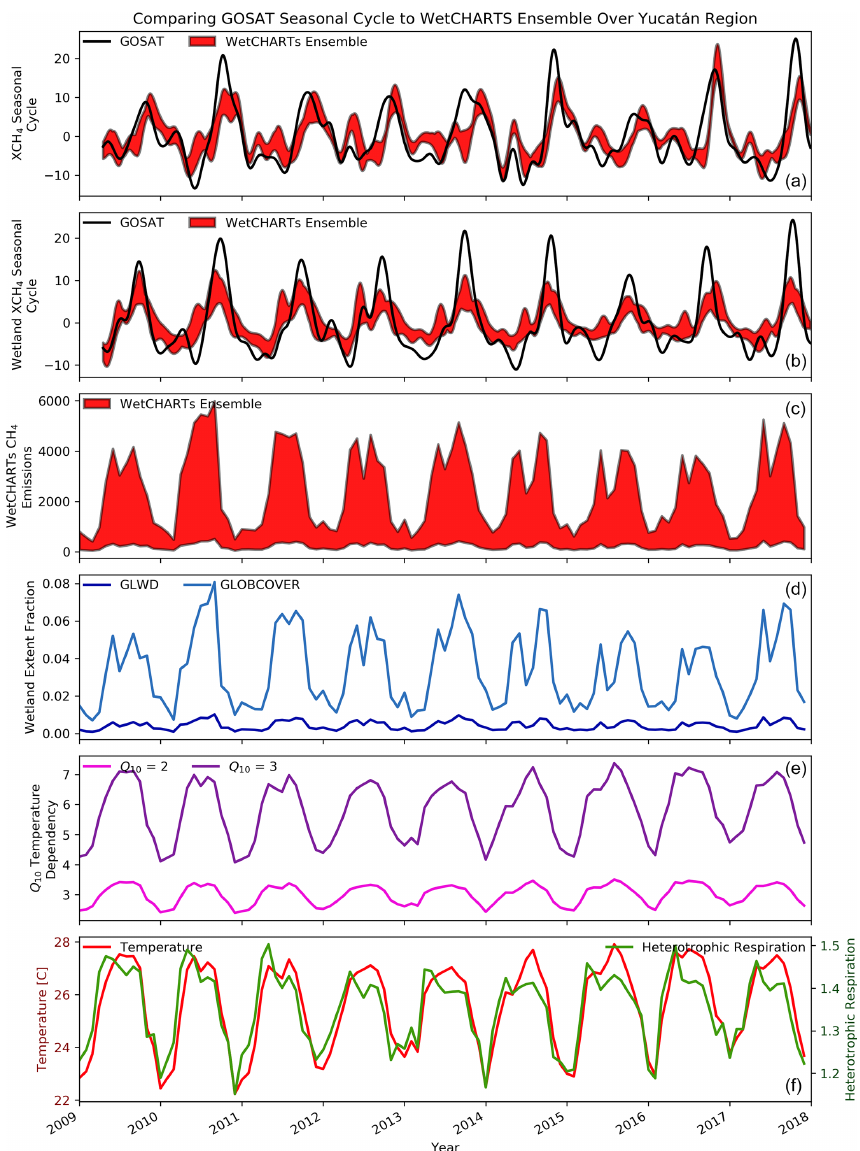
Figure 16. Time series over the Yucatán wetland region showing (a) the GOSAT and WetCHARTs CH 4 ensemble seasonal cycle, (b) the wetland component of the above seasonal cycles once the modelled data with no wetland emissions have been subtracted, (c) the ensem- ble of WetCHARTs CH 4 emissions, (d) the wetland extent fractions, (e) the Q 10 temperature dependencies, and (f) the temperature and heterotrophic